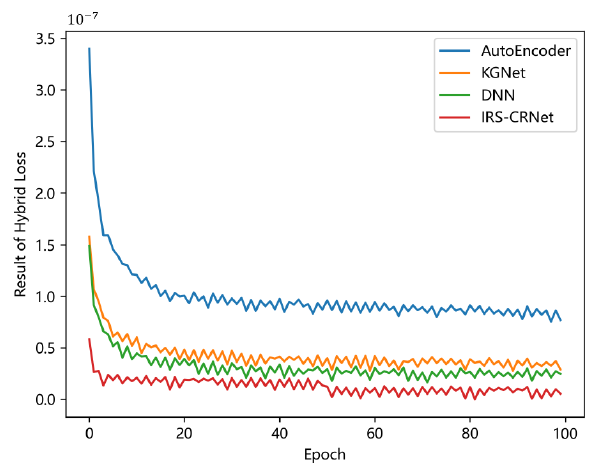
Figure 6. The result of Loss h of four different models versus the epoch of the training process.